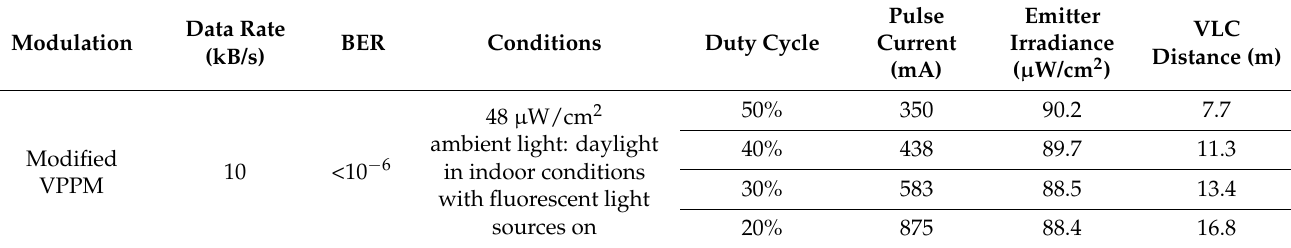
Table 6. Summary of the experimental results showing the viability of the range increasing mechanism for the braking light